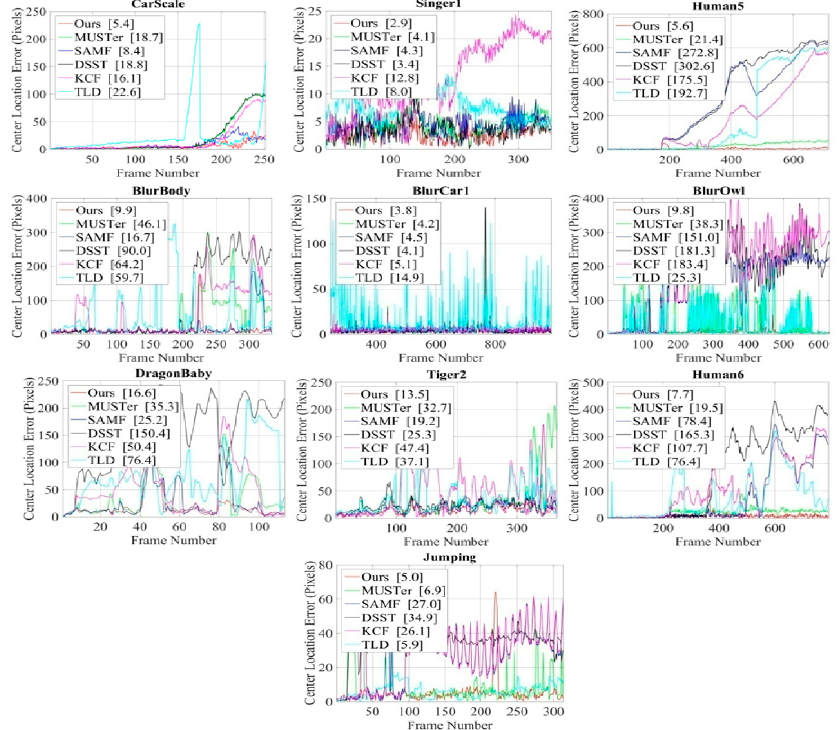
Figure 9. Center location error results for 10 challenging sequences.